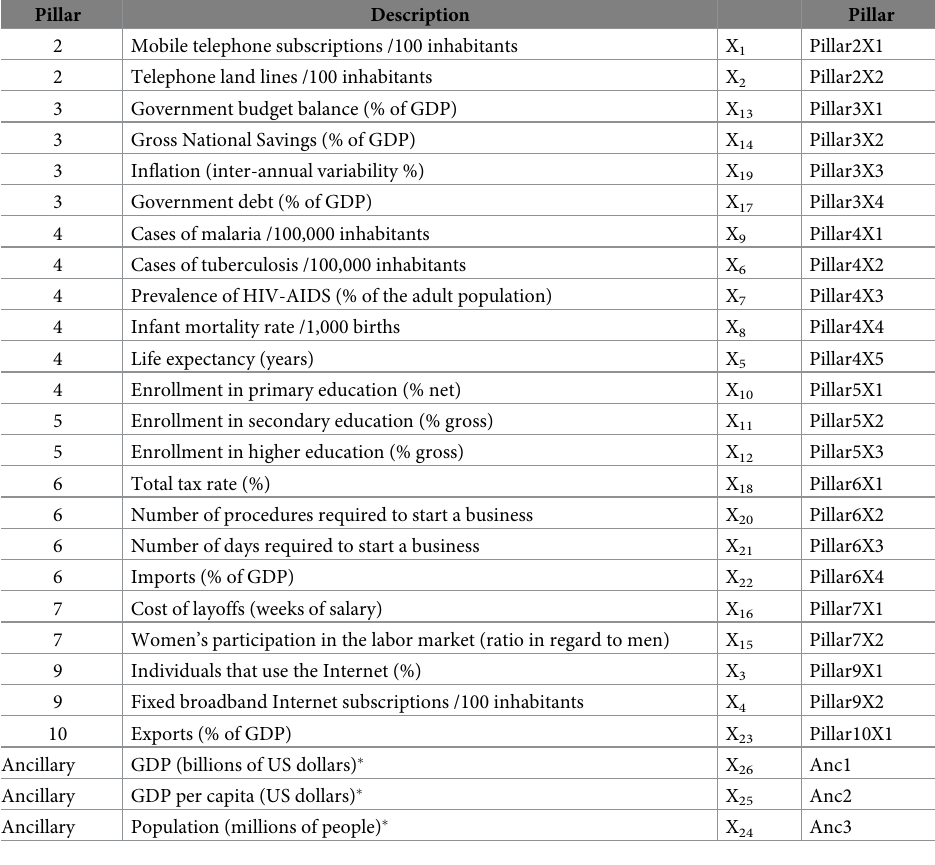
Table 3. Indicators used to compute